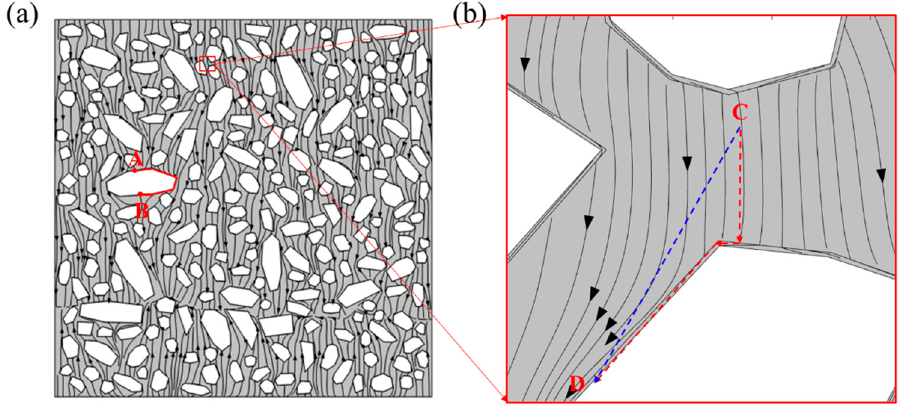
Figure 12. Chloride diffusion trajectories in meso ‐ structures of concrete. ( a ) Overall concrete section ( b ) Local amplification.